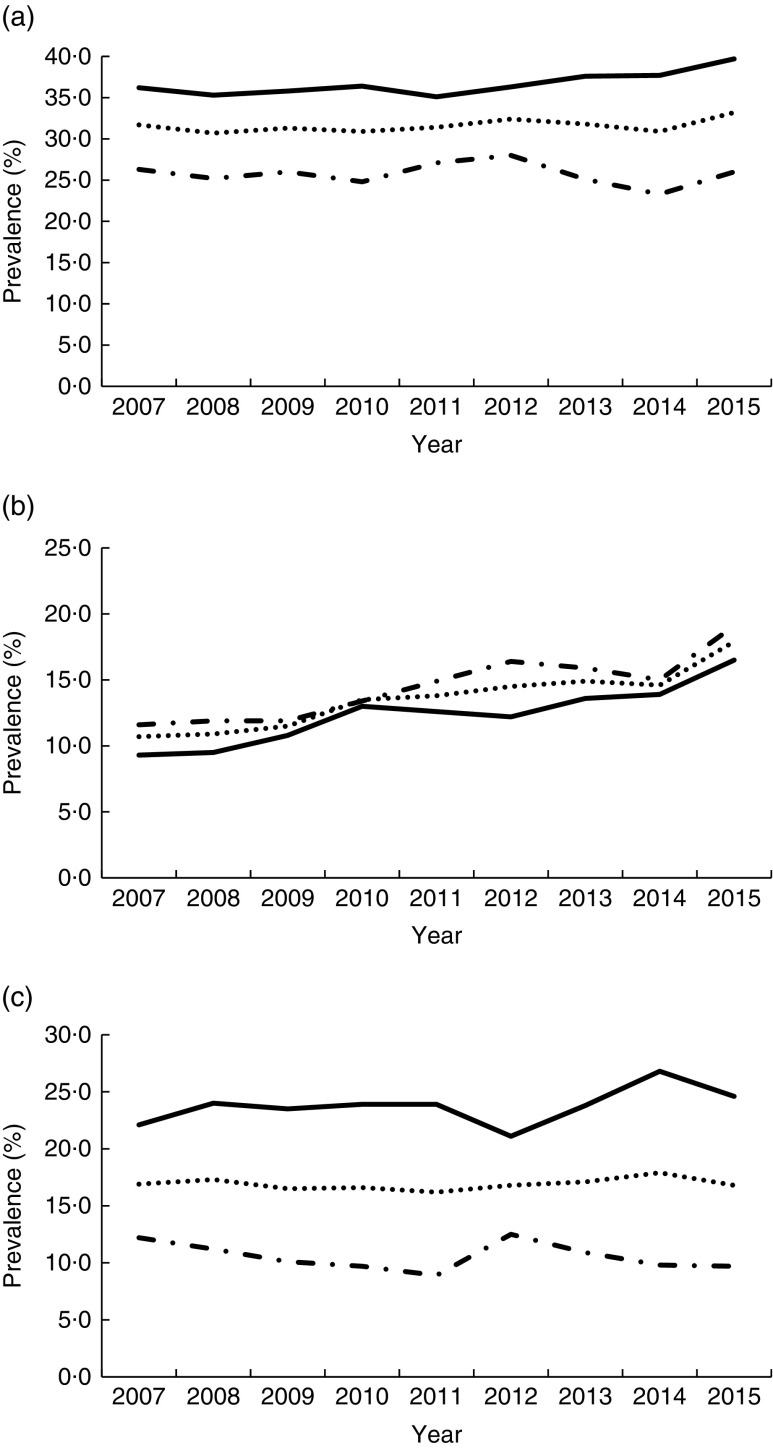
Prevalence of chronic health conditions in Korean adults from 2007 to 2015 by sex (, total; , male; , female): (a) obesity; (b) hypercholesterolaemia; (c) hypertriacylglycerolaemia. Data from Korea Health Statistics 2015 report published by the Korea Centers for Disease Control and Prevention(

20

)